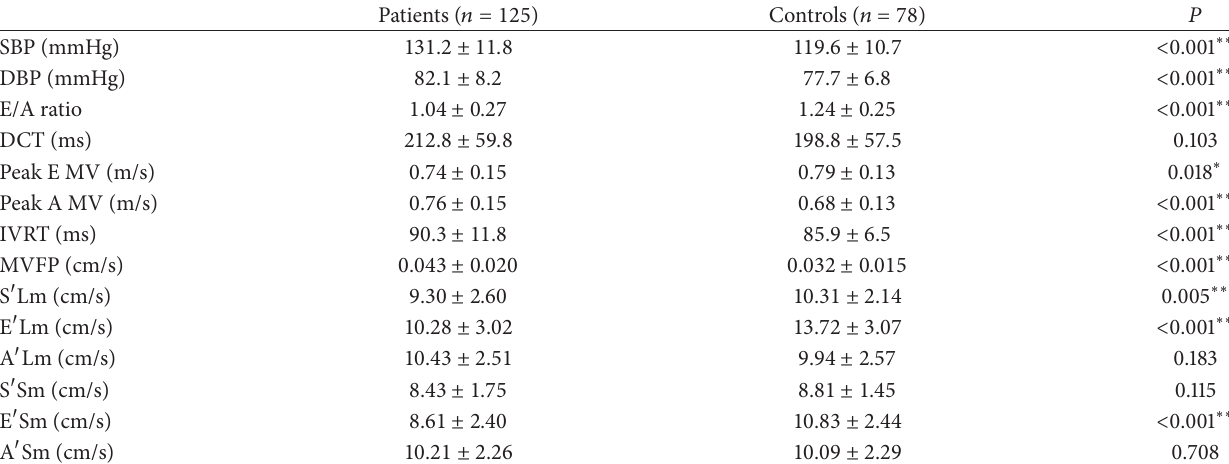
Table 4: Transmitral and tissue Doppler imaging parameters of OSA patients and control